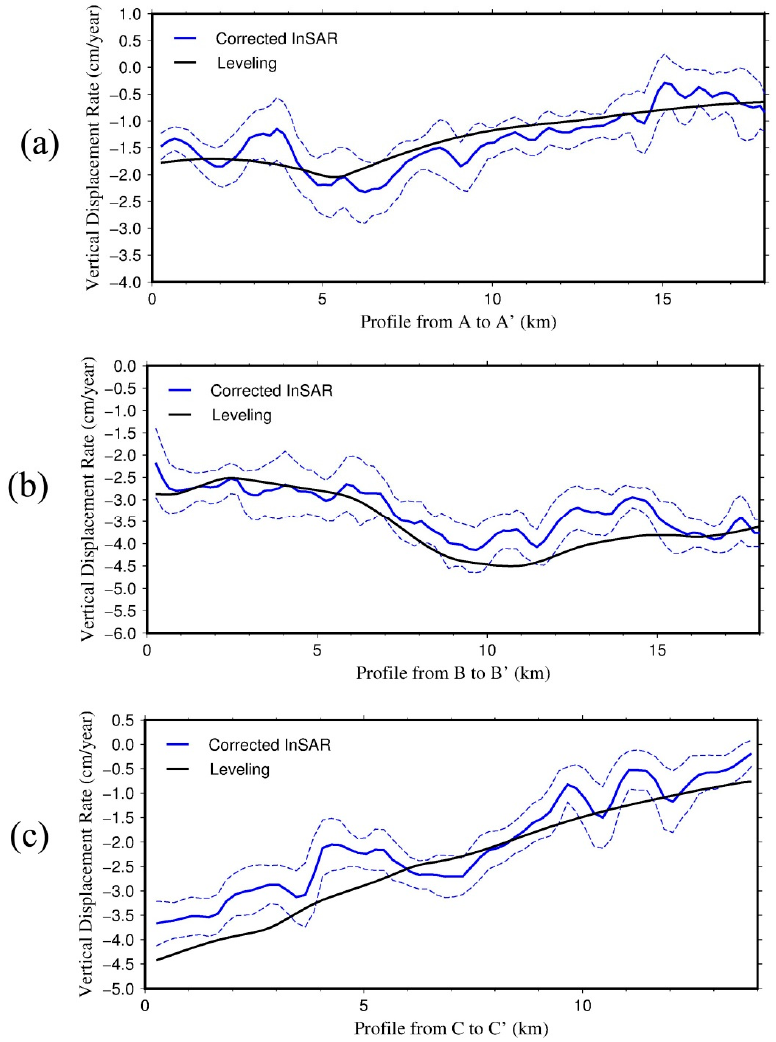
Figure 13. Vertical displacement rates from the merged field (the corrected InSAR result) along the three profiles ( a ) A-A’, ( b ) B-B’, and ( c ) C-C’ in Figure 12. The dash lines show the 90%-confidence regions of the InSAR-derived rates.